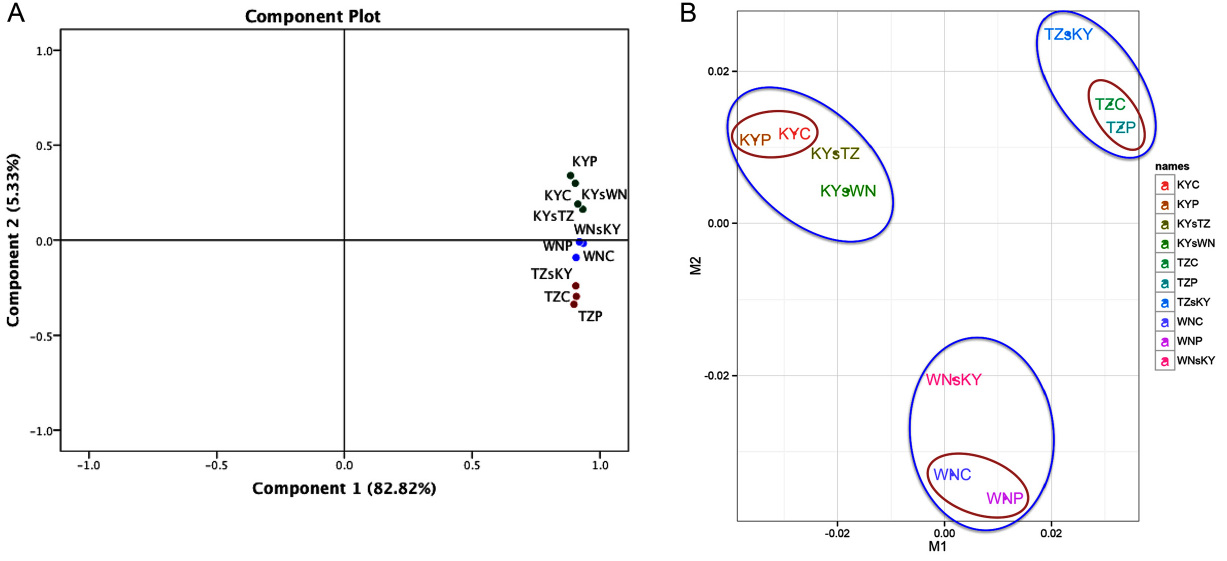
Figure 1. PCA and MDC plots of log -normalized FPKM of ten RNA-seq samples. In the 2 PCA plot ( A ); green, blue, and brown discs represent samples from KY, WN, and TZ, respectively; In the MDS plot ( B ), the brown and blue ellipses indicate transcriptomic variation affected by TFs and CFs,